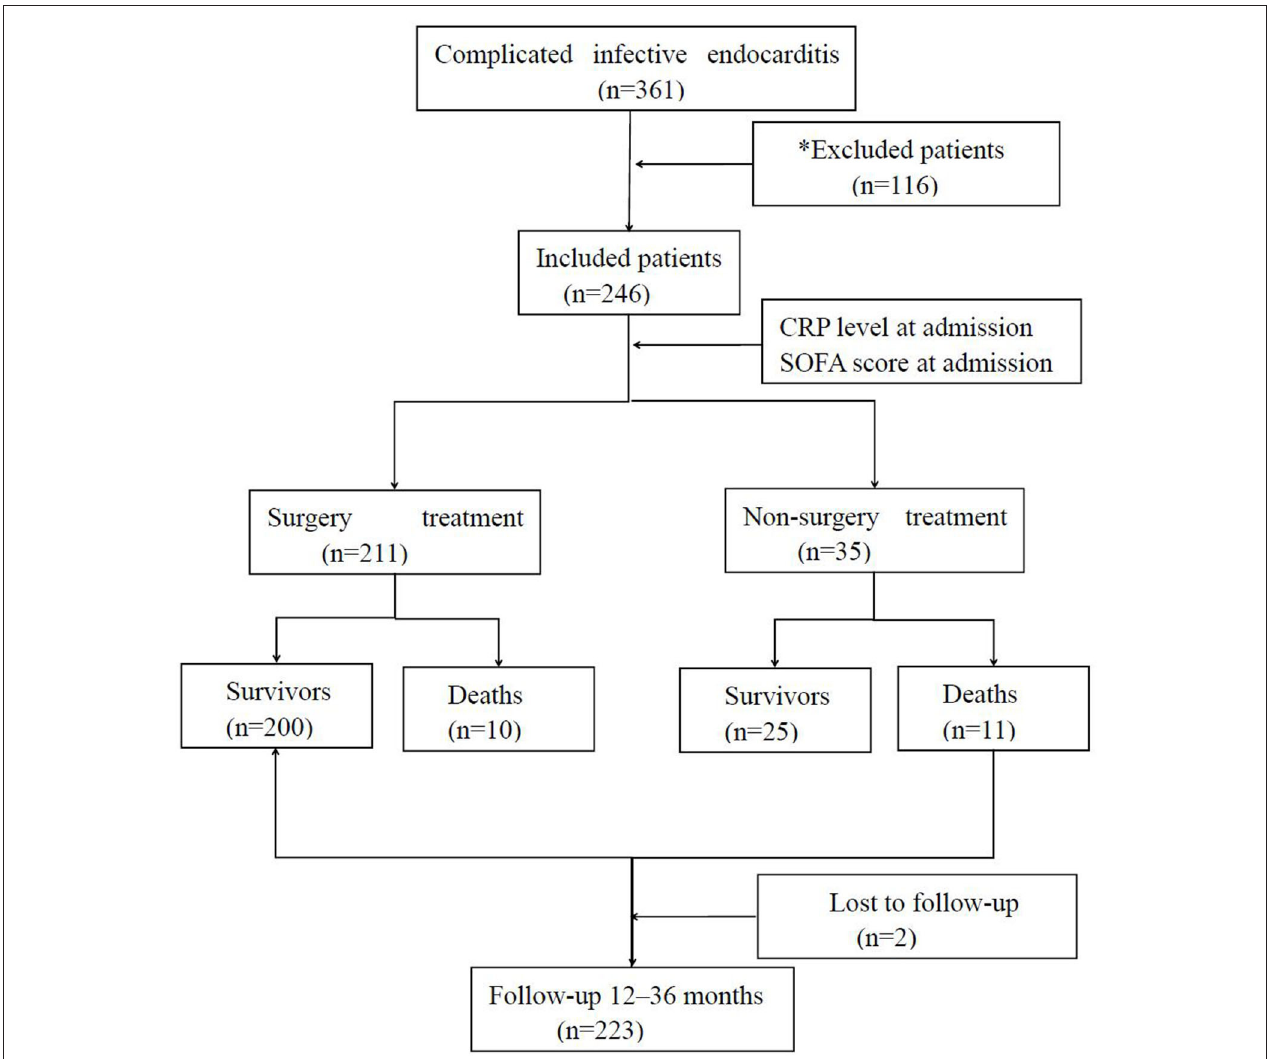
FIGURE 1 | Flowchart of the statistical analysis. *Patients were excluded on having non-complicated infective endocarditis ( n = 90), prior infective endocarditis ( n = 10), age < 18 years ( n = 12), and others ( n =